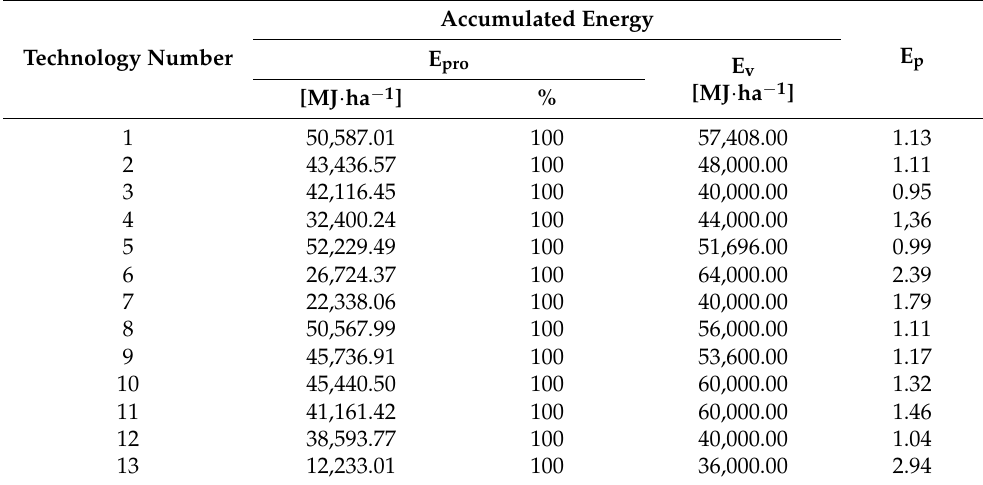
Table 5. Energy expenditure in means of production, energy accumulated in yield, and energy efficiency